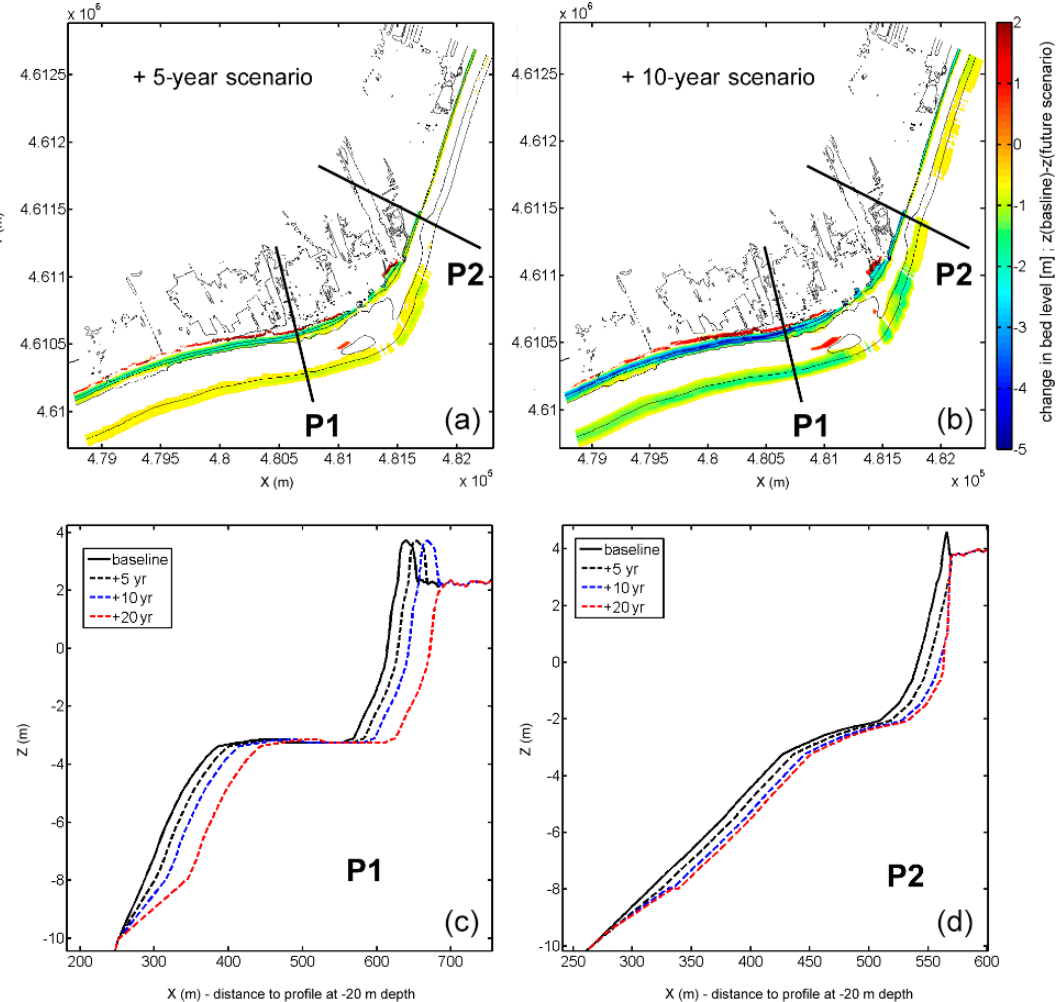
Figure 5. Changes in the bed level grid for the future scenarios. Difference between baseline bed level and scenario bed level (a, b) . Profile retreat at both sides of the river mouth at the different time horizons (c, d) . P1 belongs to MS1 (retreat of 4m/yr) and P2 belongs to SBM (retreat of